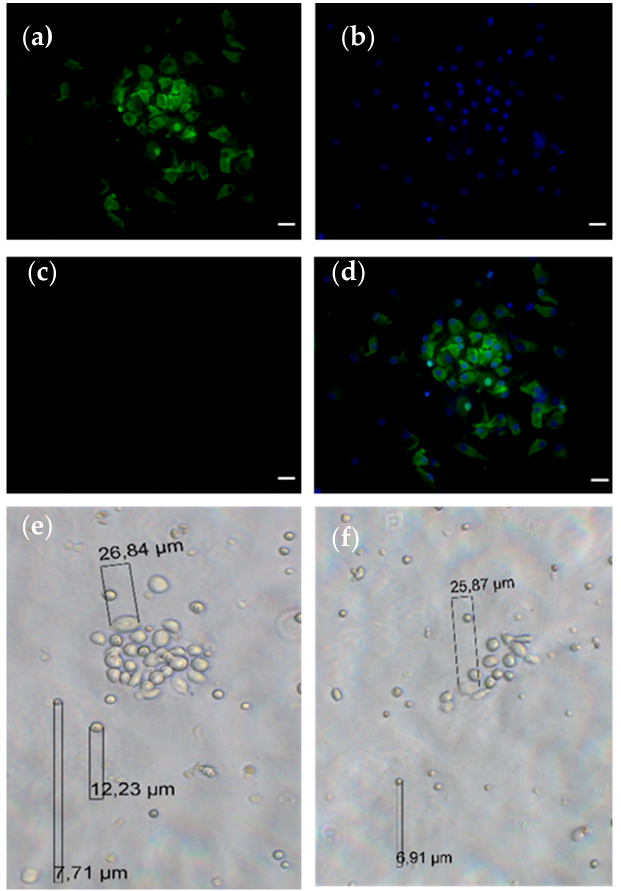
Figure 6. Representative images of cultivated CTCs. The CTCs display positive staining for ( a ) CK 8, 9 and 18, ( b ) Hoechst 33258 staining, ( c ) CD45 negativity and ( d ) overlay of images ( a – c ). Scale bar presents 20 µm. Brightfield images of growing CTCs ( e , f ).